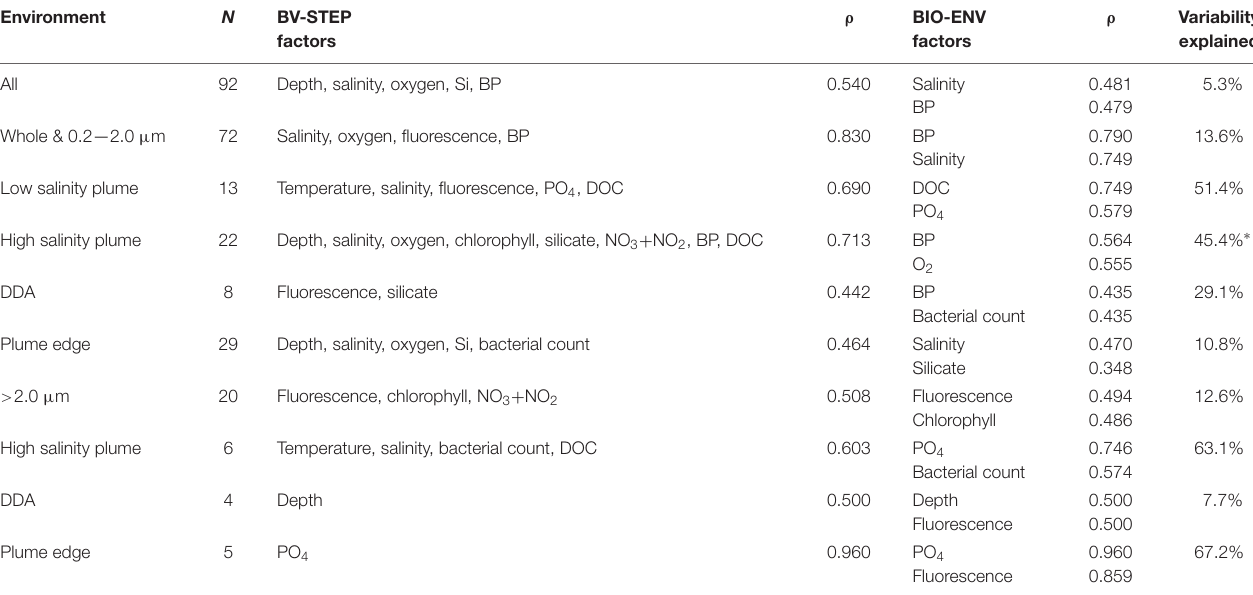
TABLE 2 | Spearman rank coefficients ( ρ ) showing correlations between environmental data and bacterial community composition for all plume and ocean samples, samples grouped by size fraction (whole, 2.0 and 0.2 µ m), and samples grouped by location for each size fraction [low salinity